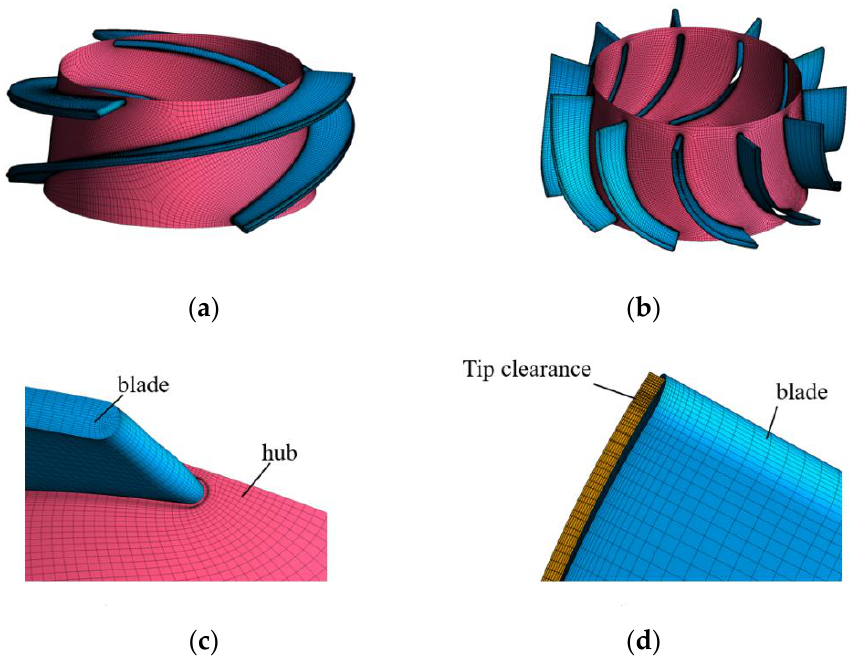
Figure 2. Computational domain grid. ( a ) Impeller. ( b ) Diffuser. ( c ) Impeller blade. ( d ) Tip clearance.